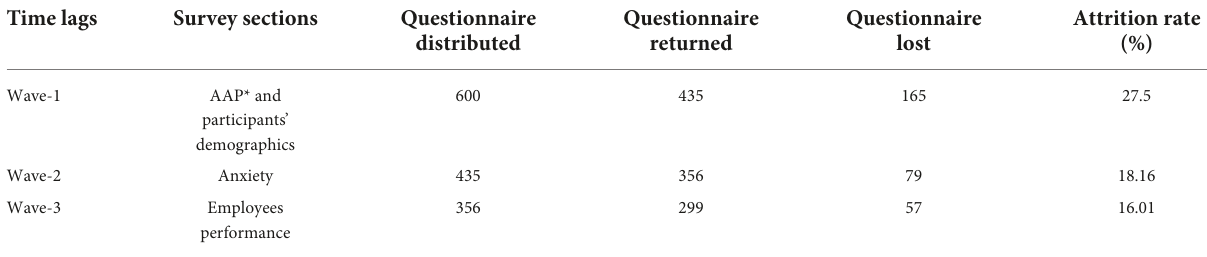
TABLE 1 Data attrition